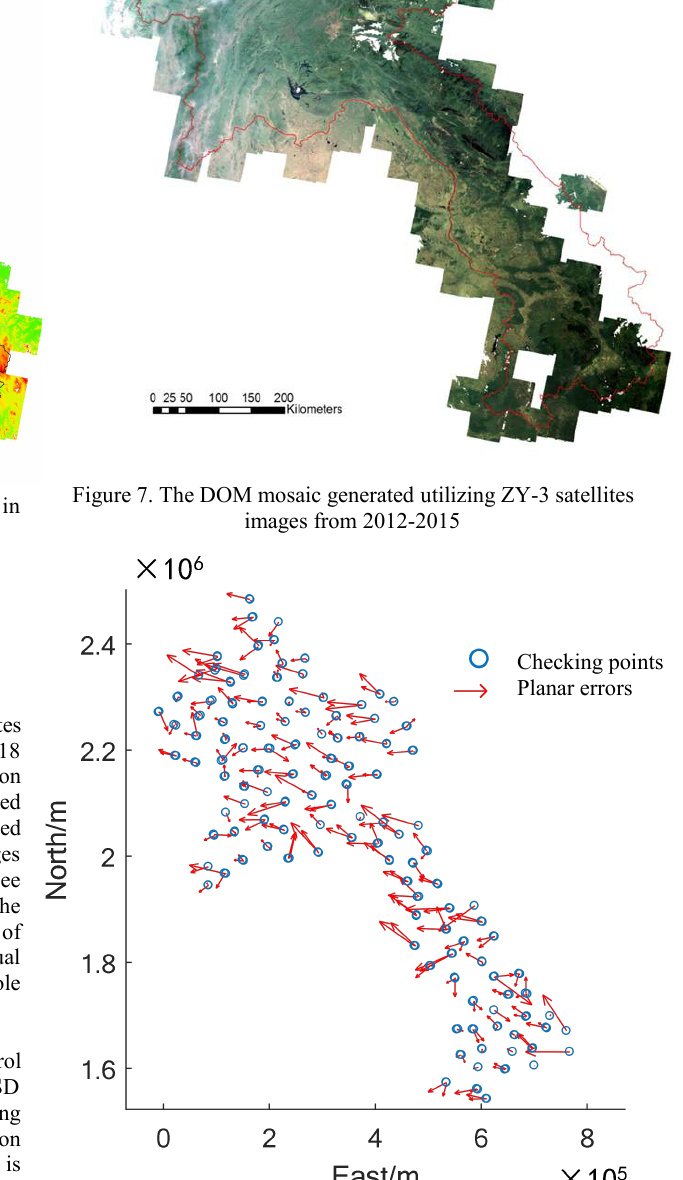
Figure 8. The planar errors of the 223 checking points